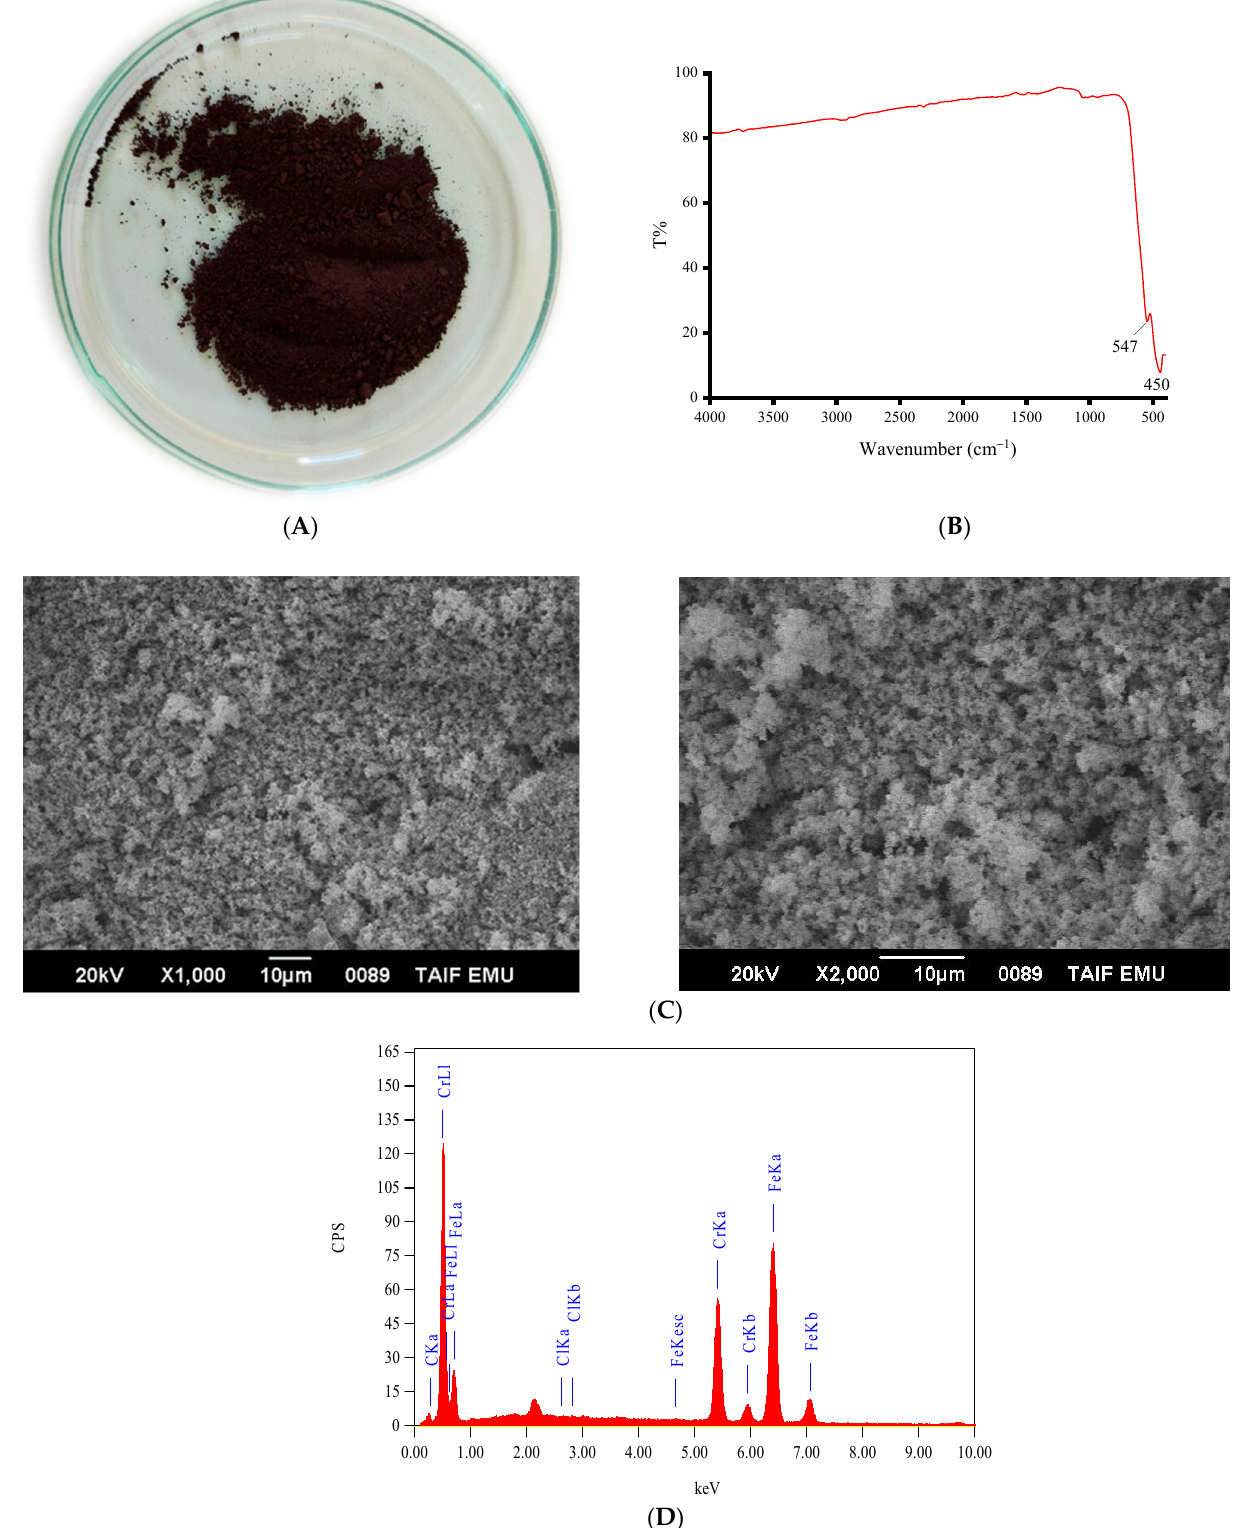
Figure 2. Characterizations of the CrFeO 3 composite: ( A ); Color and shape of the product, ( B ); IR spectrum, ( C ); SEM image, and ( D ); EDX pro fi le.